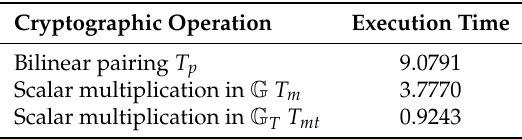
Table 2. Time cost of cryptographic operation.